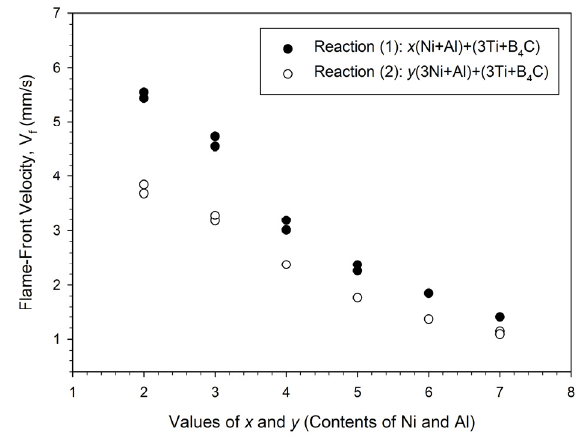
Figure 2. Effects of Ni and Al contents on flame-front velocities of Reactions (1) and (2).